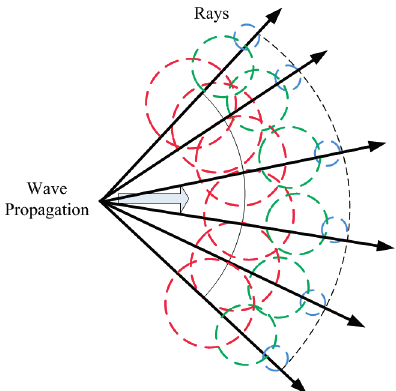
Figure 1. Wave front propagation with rays associated with single wave front points.